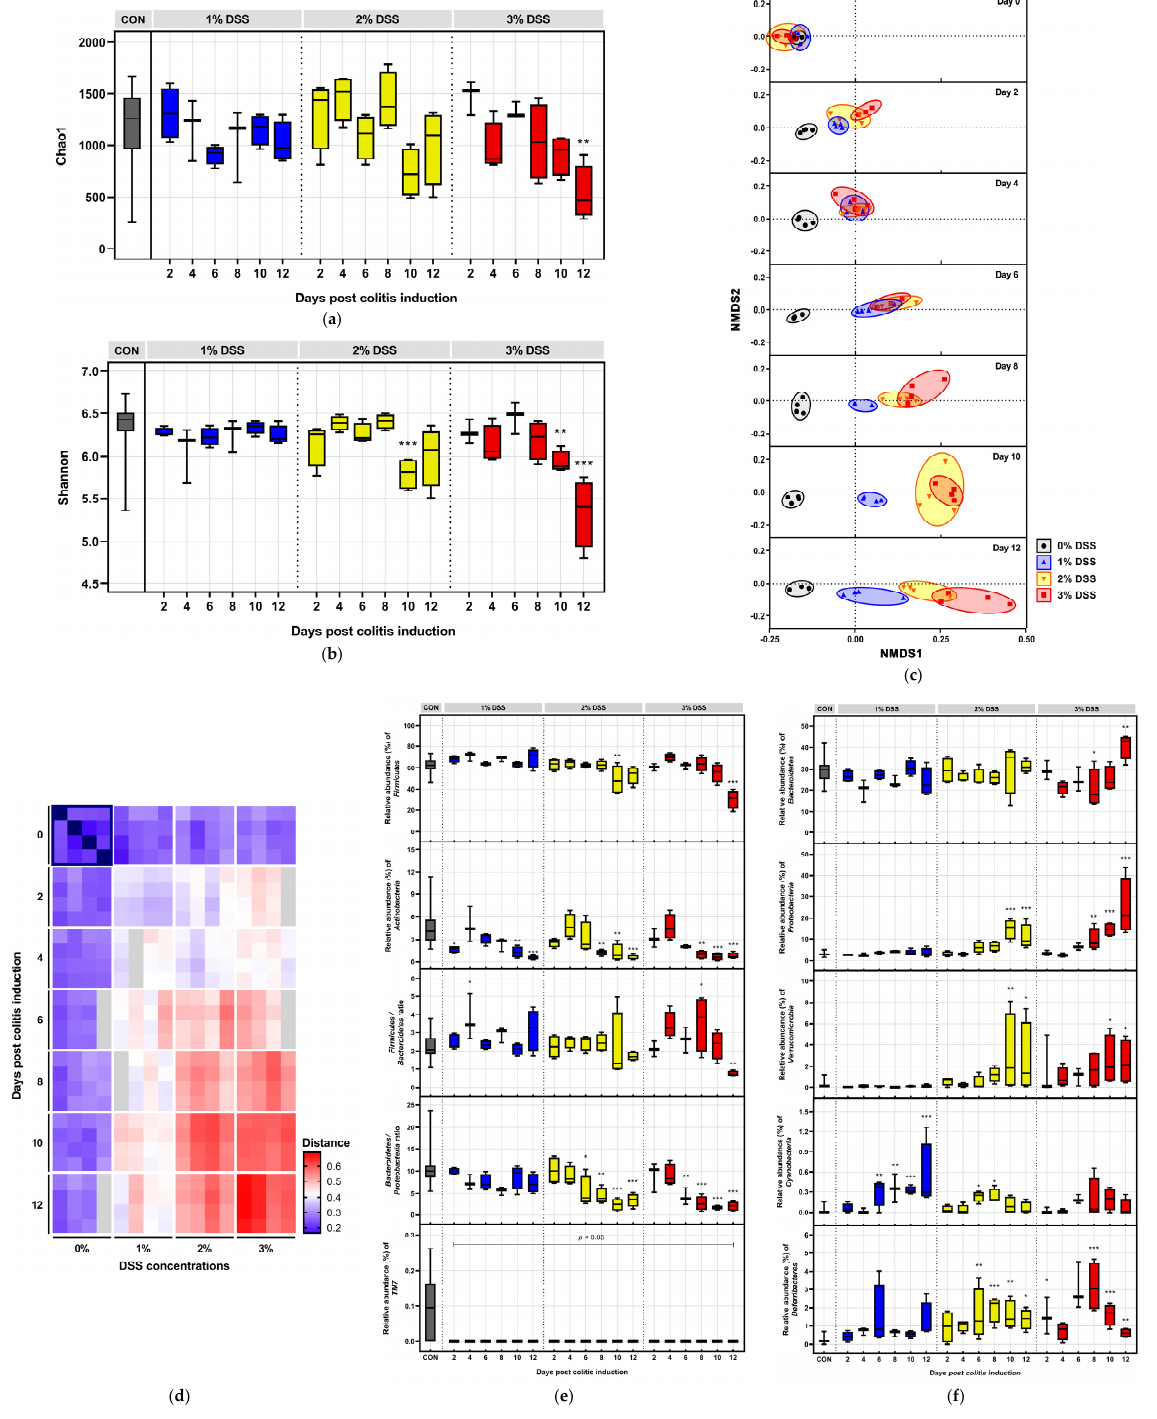
Figure 2. DSS-driven changes in microbial diversity, phylogenetic ordinations, and populations at the phylum level. Alpha diversity estimated as ( a ) Chao1 and ( b ) Shannon indices during DSS colitis induction. ( c ) Nonmetric multidimensional scaling (NMDS) plot of GUniFrac distances. ( d ) Pairwise distance of individuals compared to the initial 0% DSS subjects in a black-lined box. ( e ) Phyla ( Firmicutes and Actinobacteria ) and population ratios ( Firmicutes / Bacteroidetes and Bac- teroidetes / Proteobacteria ) that decreased with increasing DSS exposure and the phylum whose abundance diminished ( TM7 ) with DSS treatment are shown. ( f ) Phyla ( Bacteroidetes , Proteobacteria , Verrucomicrobia, Cyanobacteria, and Deferribacteres ) that increased with increasing DSS exposure. Statistical significance compared to the negative control values is indicated as follows: * p < 0.05, ** p < 0.01, and *** p <